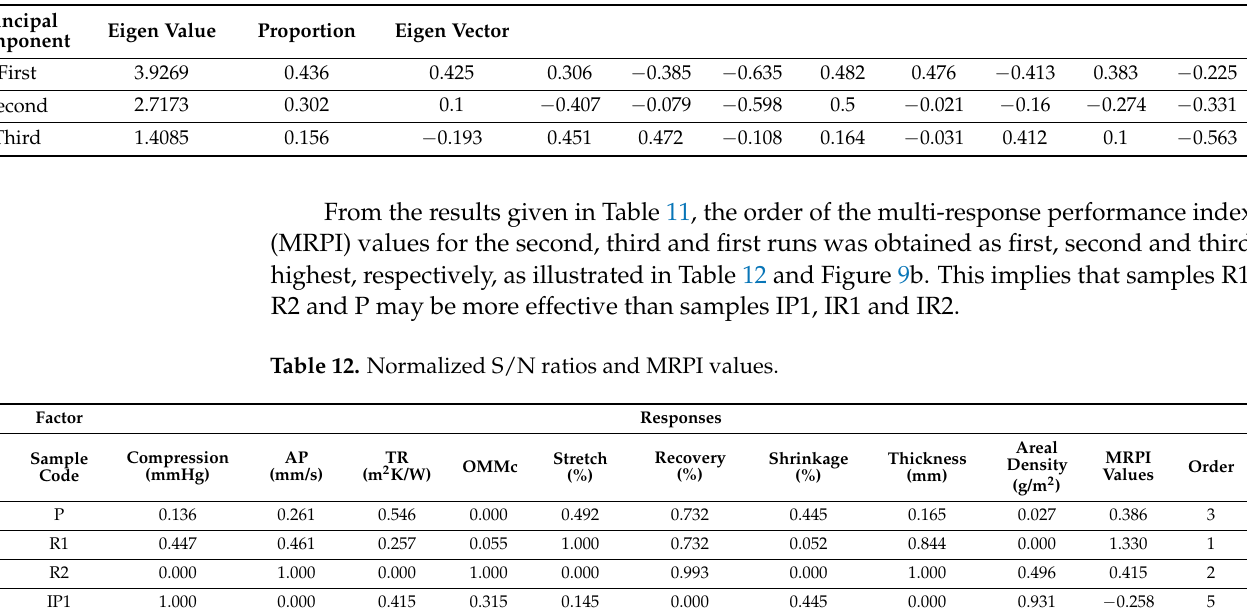
Figure 9. Scree plot and MRPI values. Table 11. Principal component analysis matrix.